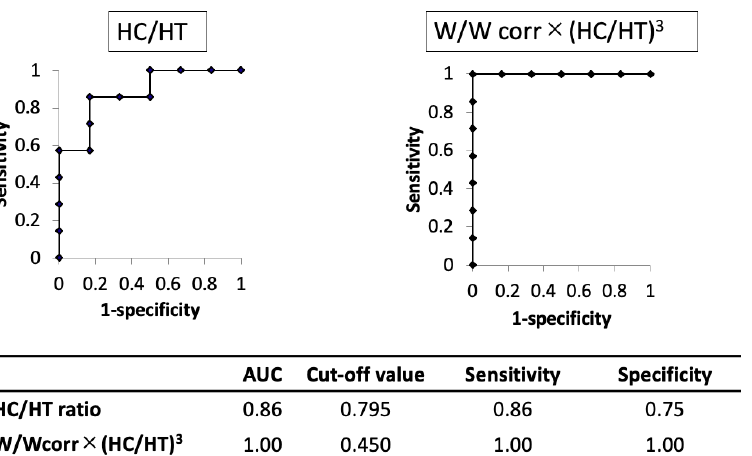
Table 1. Detailed data of 11 newborns with a fetal femoral length of <−3.0 standard deviation score for the gestational age.